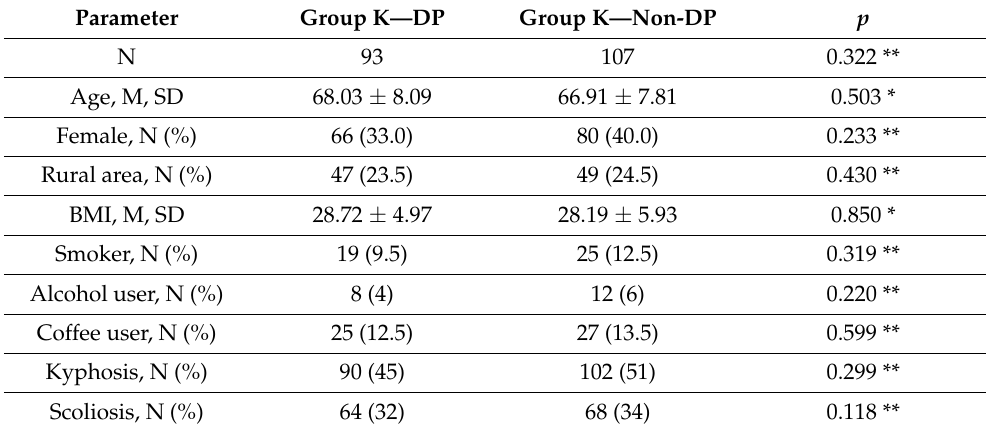
Table 1. Baseline characteristics of the groups.